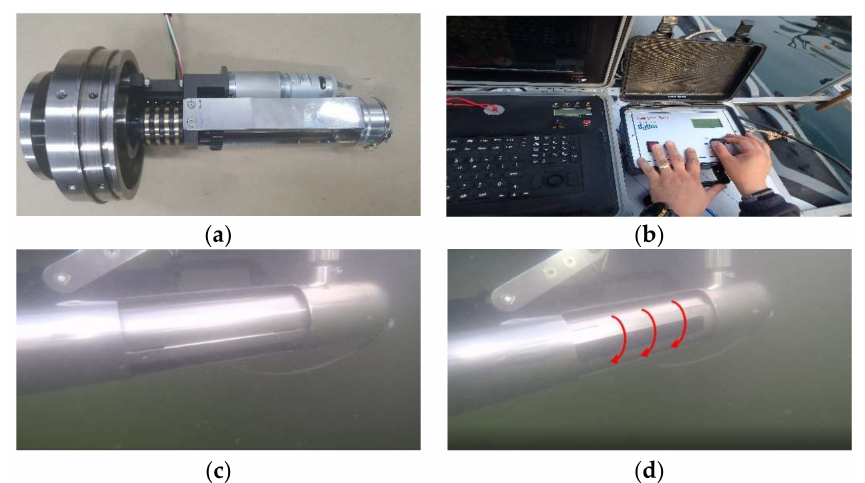
Figure 4. Electric jig. ( a ) DC Reduction motor; ( b ) Control box; ( c ) 2 MHz Sonar rotation (1); ( d ) 2 MHz Sonar rotation